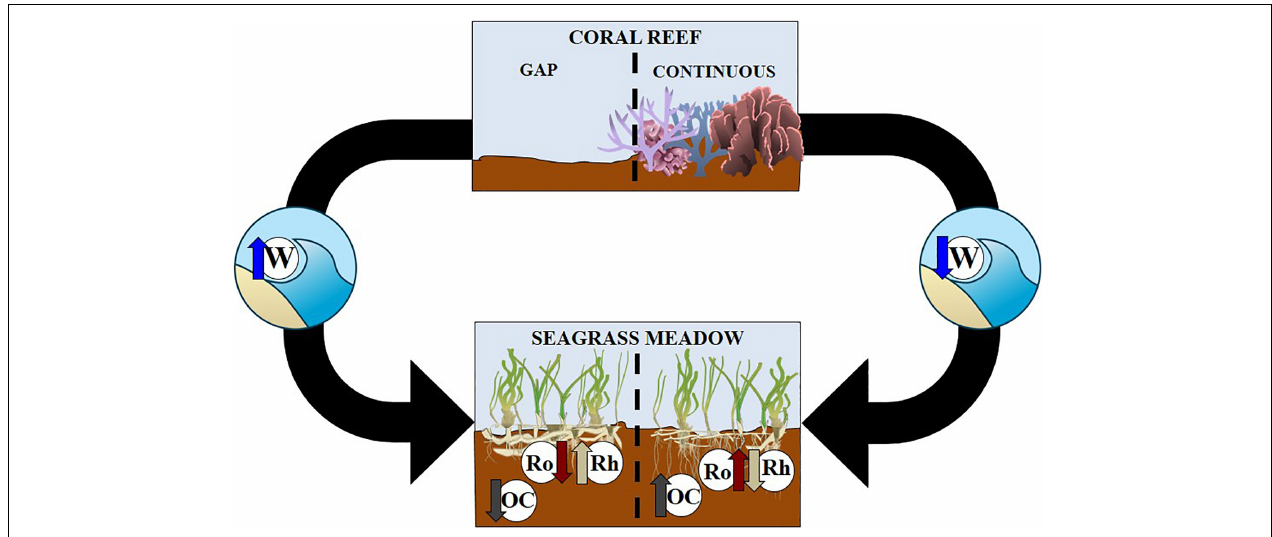
FIGURE 8 | Conceptual diagram showing connected seascape of coral reefs (upper section) and seagrass meadows (lower section). Black arrows indicate connections between coral reefs with a gap (left hand side) and continuous (right hand side) with seagrass meadows. Letters are as follows W is waves, OC is sediment organic carbon, Ro represents roots and Rh is seagrass